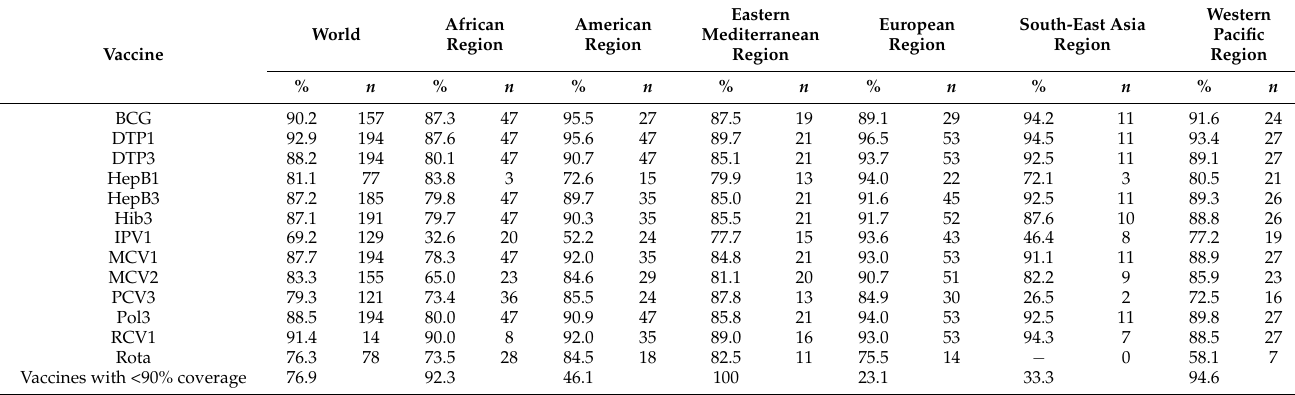
Table 2. Mean vaccination coverage for different routine vaccines in different regions of the World Health Organization in 2015.